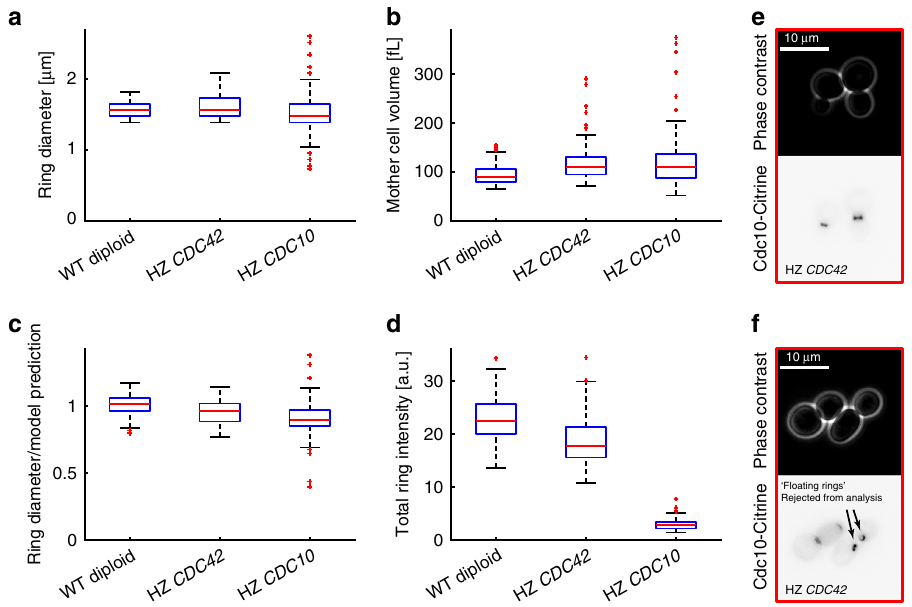
Fig. 7 Diploid cells hemizygous for CDC42 or CDC10 with normal ring morphology have a similar ring diameter compared with wild-type diploids. Cell volume and septin ring diameter based on Cdc10-mCitrine fl uorescence were measured in diploid cells hemizygous for CDC42 (63 cells pooled from four independent experiments) or CDC10 (100 cells pooled from two independent experiments) and compared with wild-type diploids (95 cells pooled from two independent experiments). Cells with obvious defects in bud formation, cytokinesis, and septin morphology were rejected from the analysis. a Boxplots showing the distribution of septin ring diameters. For each cell, the median ring diameter during the time when the ring is detected is measured. b Boxplots of the median cell volume during that time. c For each cell, we compare the measured ring diameter to the value expected for wild-type diploid cells with the same mother cell volume based on the power law fi t obtained for wild-type and inducible-Whi5 cells grown on SCGE shown in Fig. 5e. Boxplots depict the distribution of the ratios of measured and expected ring diameters. d Boxplots of the median total fl uorescence intensity (integrated line pro fi le intensity after background subtraction) during the time when the ring is detected. Diploid cells with mCitrine-tagged Cdc10 and hemizygous for CDC42 often show obvious defects in septin ring morphology, including a frequent occurrence of stable, “ free- fl oating, ” fl uorescent rings. Live-cell microscopy images (phase contrast (top) and mCitrine fl uorescence (bottom)) show typical examples of normal ring morphology included in the analysis ( e ), and cells with obvious defects in septin morphology rejected from the analysis ( f ). Cells were grown on SCGE. Boxplots depict medians, and 25 and 75 percentiles. Whiskers denote extreme values still within 1.5 interquartile ranges, red symbols denote outliers. Source data are provided as a Source Data fi